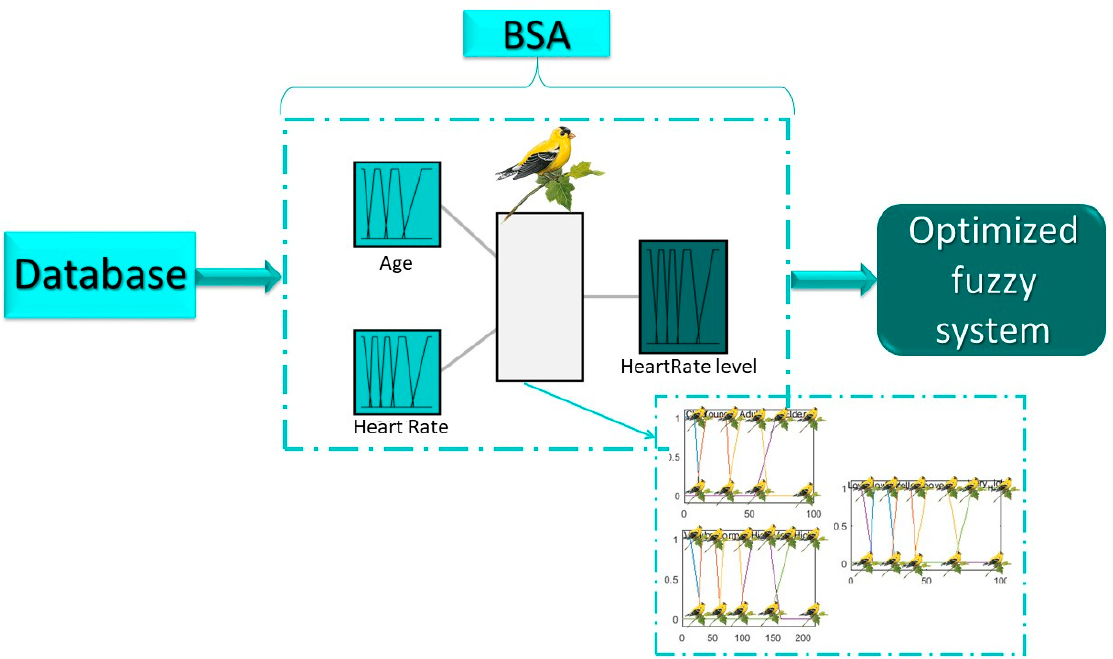
Figure 2. Proposed methodology.